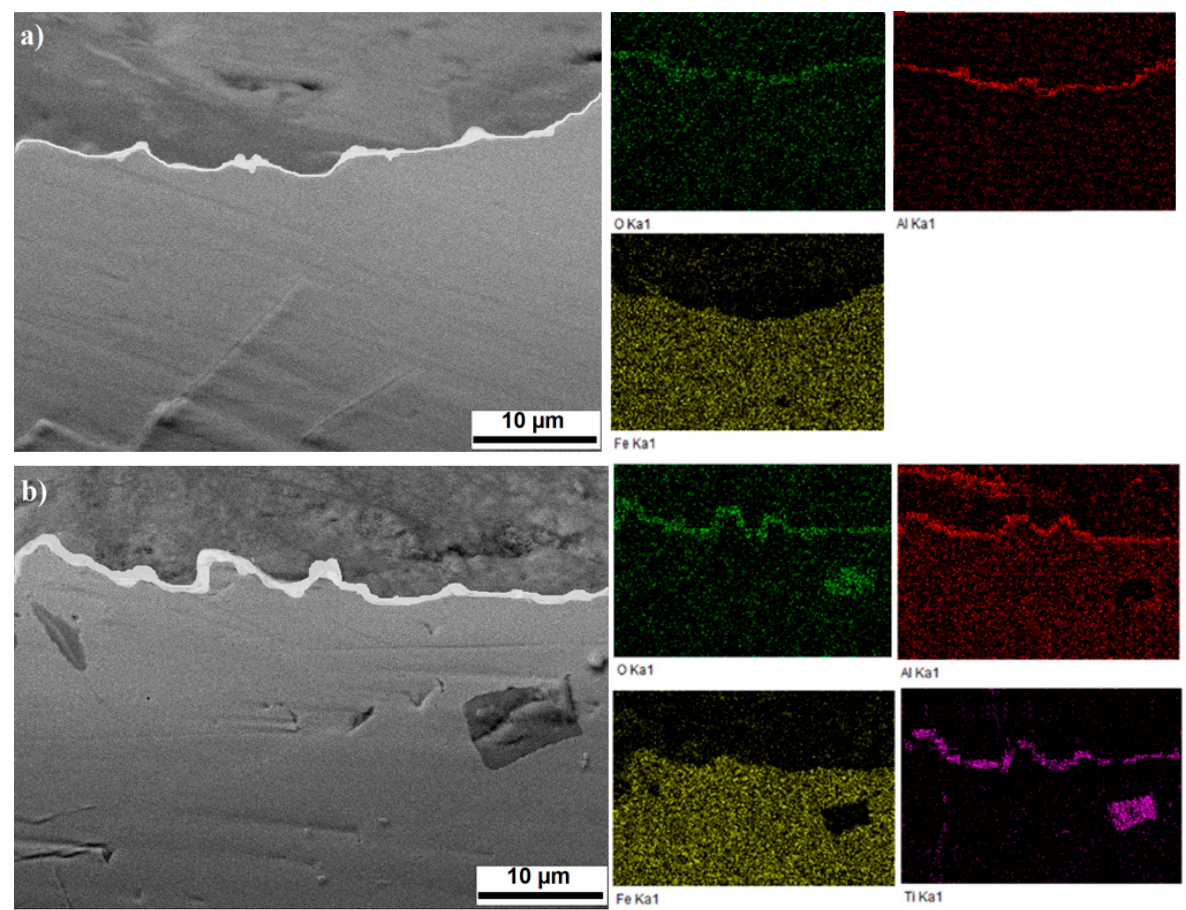
Figure 5. X-ray diffraction (XRD) patterns of oxidized samples.